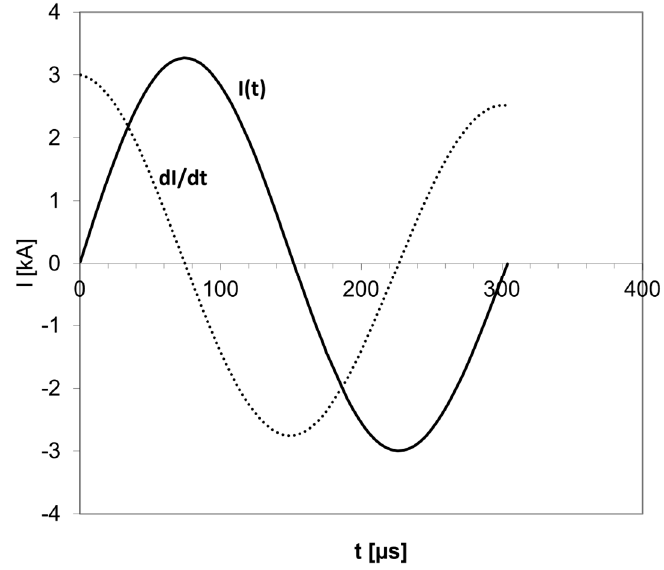
Figure 1. A typical biphasic current pulse in TMS. The current I is in Kiloampere (kA), and the pulse duration is in microseconds. In a biphasic pulse, the current flows in one direction with increasing amplitude, then the amplitude goes down to zero, and the current flows in the other direction. The current I pulse has a sinusoidal shape. The electric field is proportional to the time derivative of the current (dI/dt) and has the shape of a cosine. The brief pulse lasts just a few hundred microseconds. The induced electric field lines are parallel to the current in the coil (Figure 2I).